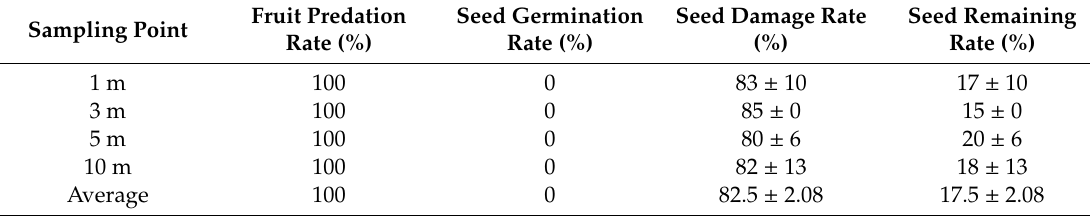
Table 4. Dynamic changes of fruit and seeds of S. × hainanensis under natural